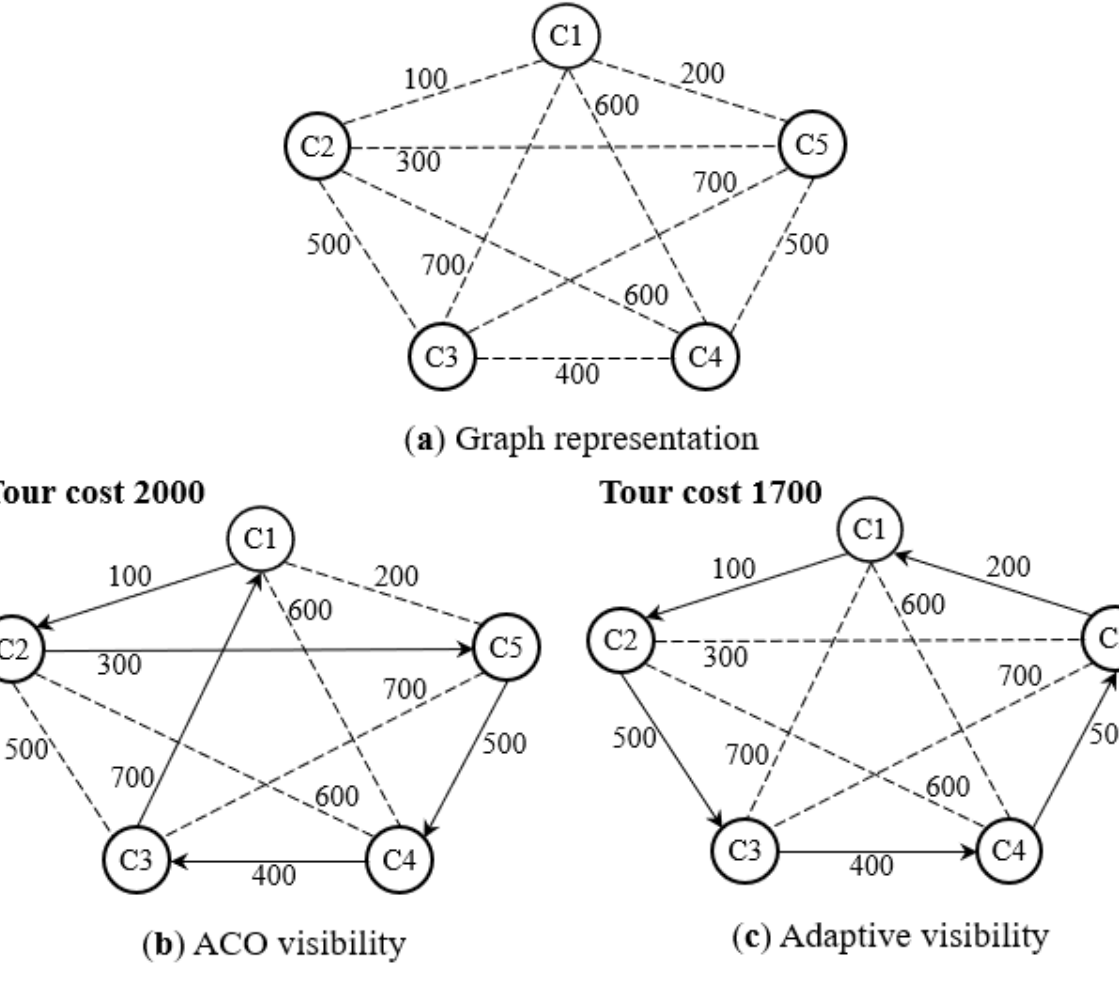
Figure 2. Demonstration of TSP solving with the proposed adaptive visibility compared with ACO visibility. Tour cost emphasizing nearest city for ACO is 2000 and tour cost with proposed adaptive visibility is 1700.